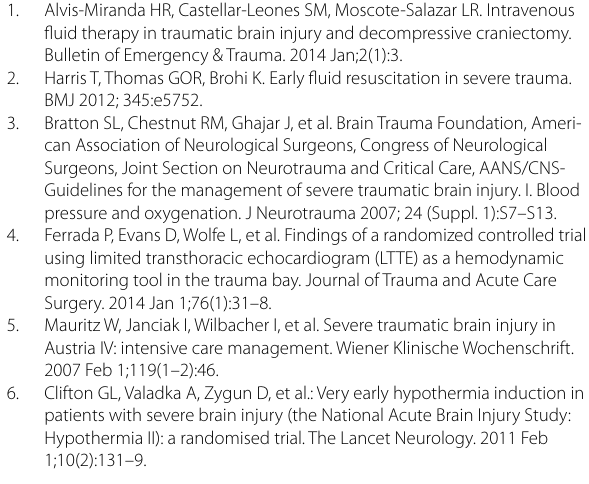
comes. It allows early understanding of how euvolaemic fluid bal- ance may improve neurological outcomes. Intervention plans based in clinical